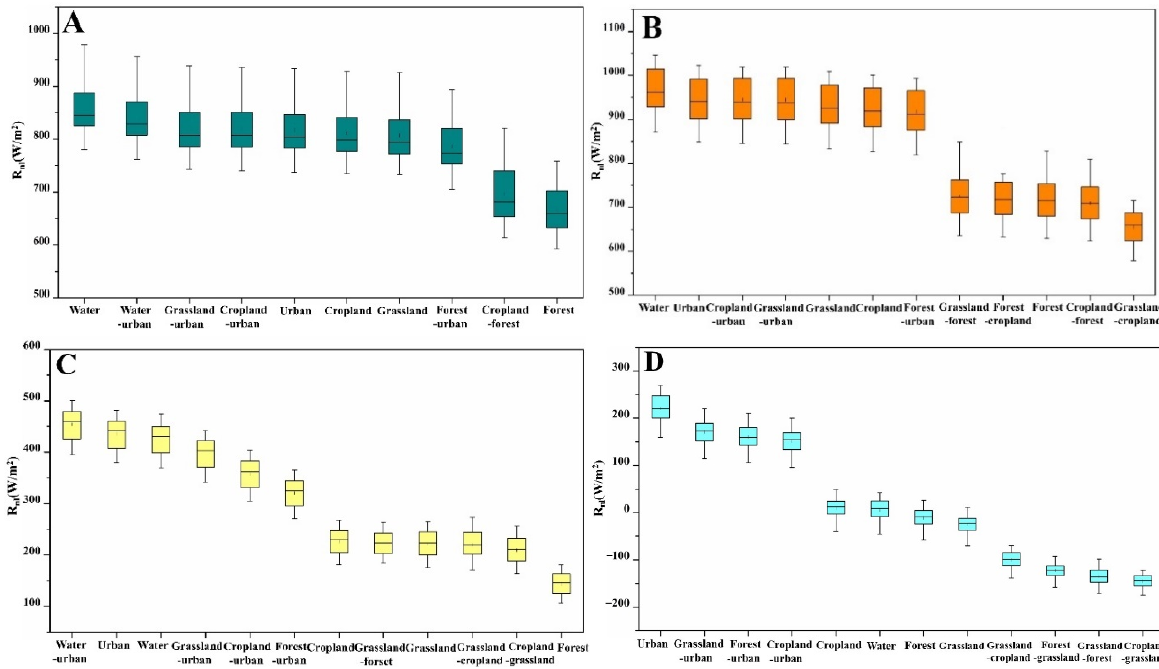
Figure 11. Statistical characteristic values of longwave radiation based on different land types from 2000 to 2015 (( A ) Jinan City, ( B ) Zhengzhou City, ( C ) Lanzhou City, ( D ) Xining City).